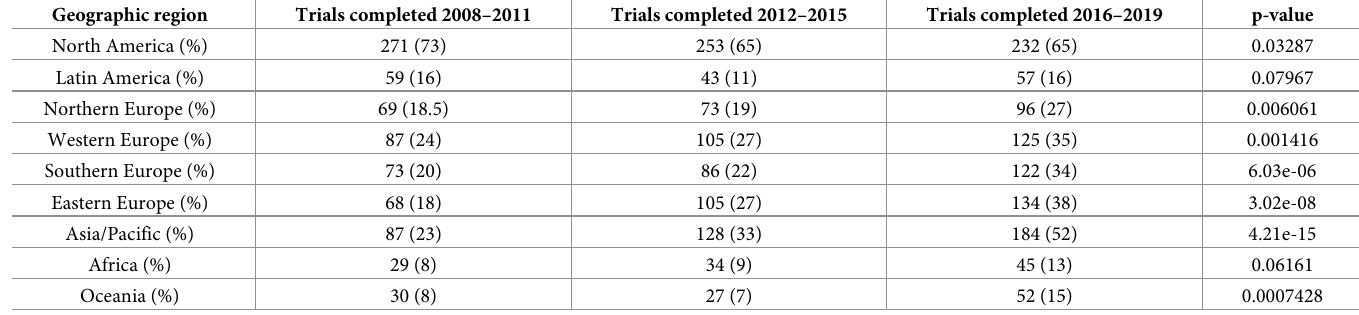
Table 3. Development of geographic location of clinical trial sites from 2008–2019 spread over 9 geographic regions including North America, Latin America, Northern Europe, Western Europe, Southern Europe, Asia/Pacific, Africa and Oceania. Each clinical trial may have registered several geographical regions. Geographic